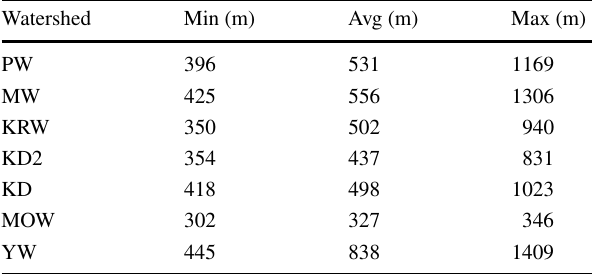
Table 6 Relief aspect of the Vaniyar sub basin